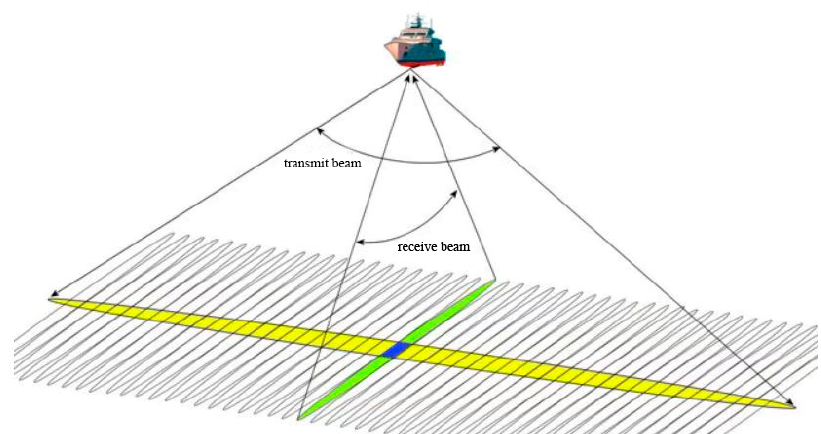
Figure 2. WBMS sounding principle diagram.